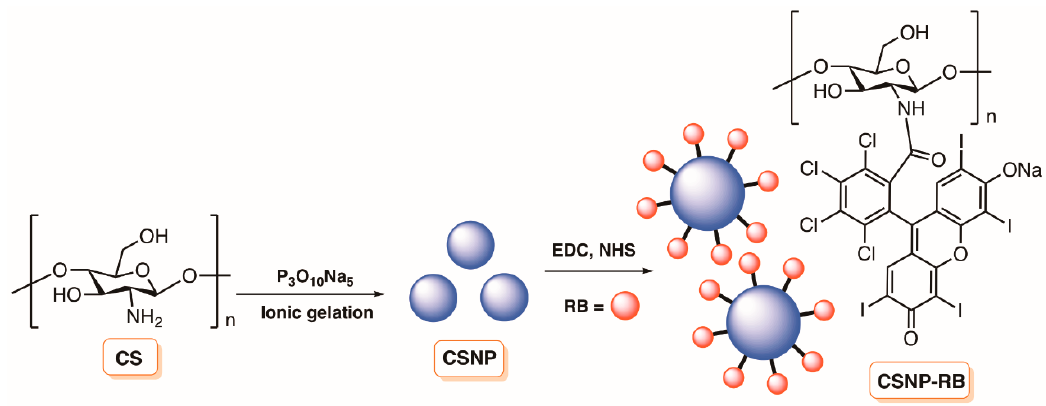
Figure 20. Conditions used to graft Rose Bengal in CSNP (adapted from Reference [121]).